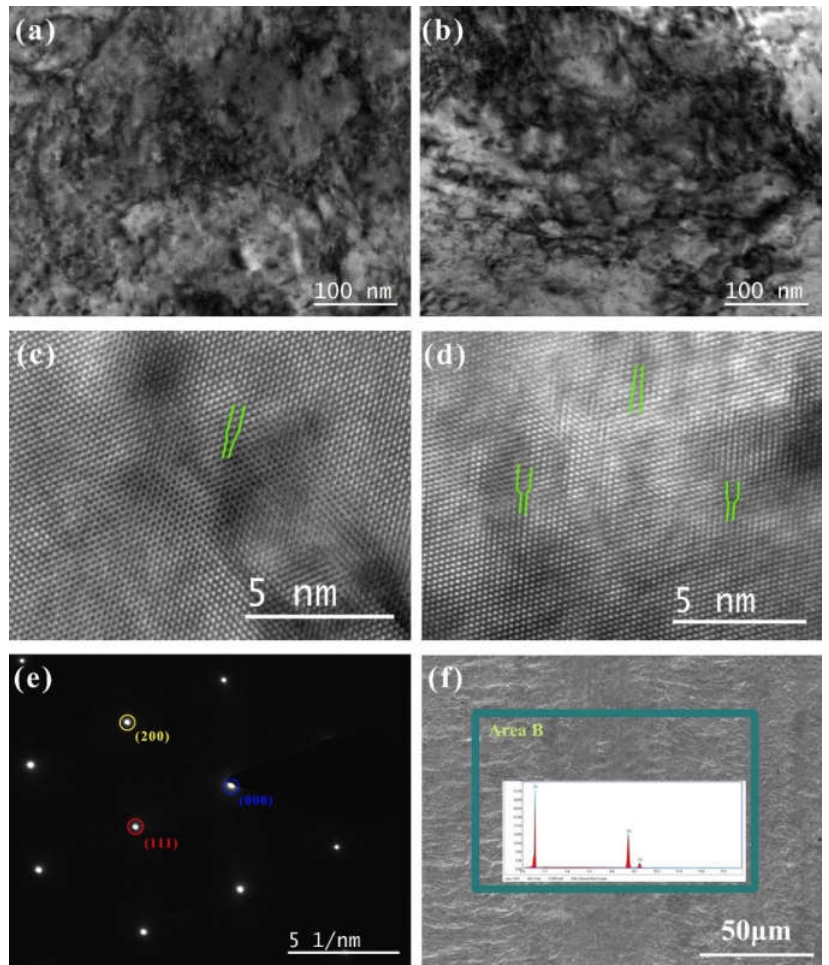
Figure 7. The morphology of TEM and HRTEM of Cu foil at DCT time ( a , c ) 0 h and ( b , d ) 12 h; ( e ) the SAED spectrum; ( f ) the SEM morphology of the original Cu foil and corresponding elements analysis.